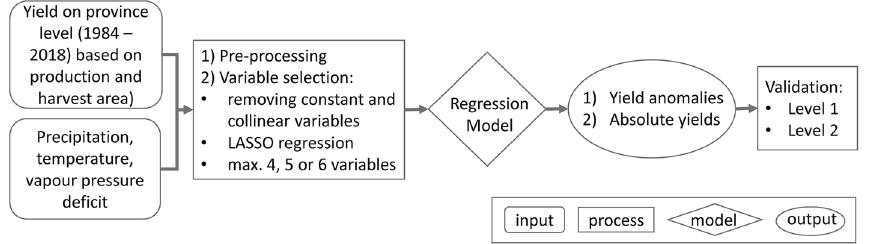
Figure 5. Yield module flow